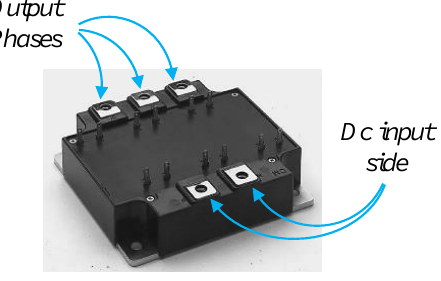
Figure 2. A commercial six-pack IGBT module.